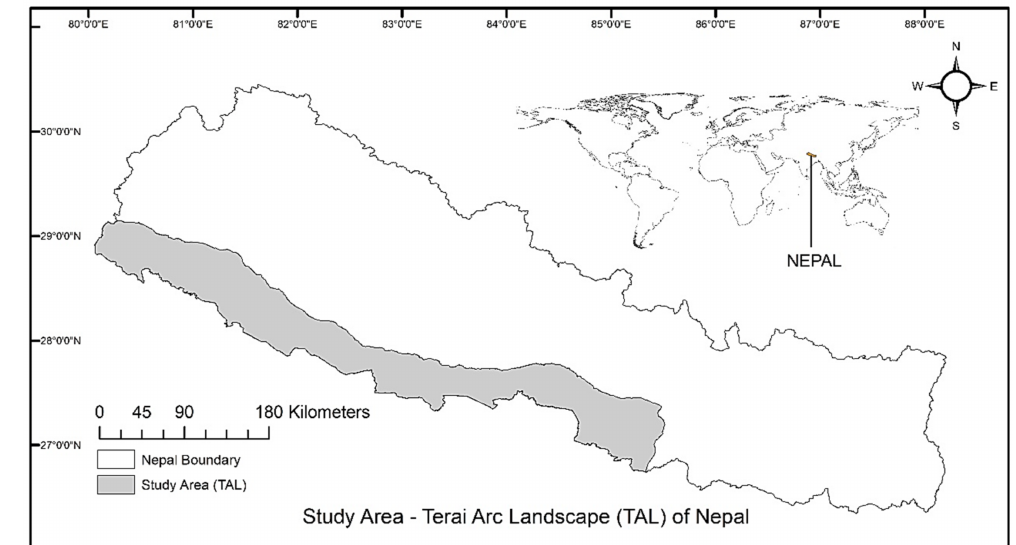
Figure 1. Map of Terai Arc